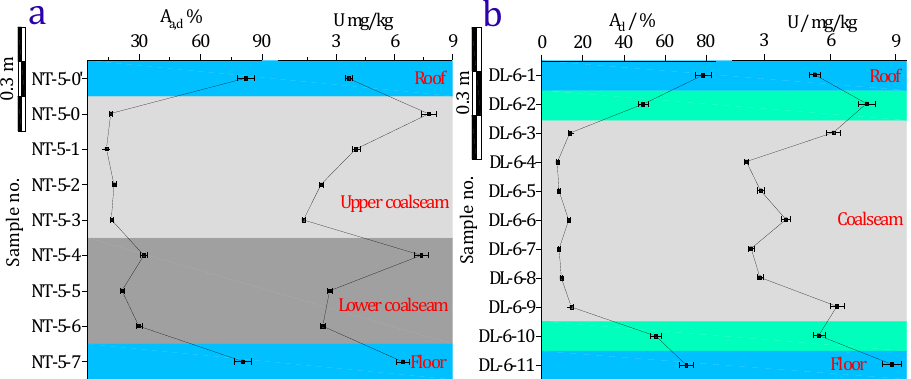
Figure 3. Vertical variation of ash yield and uranium in the Nos. 5 ( a ) and 6 ( b ) coals from the Nantong coalfield in Chongqing, southwestern China. Panel b was cited from Chen et al. [67].